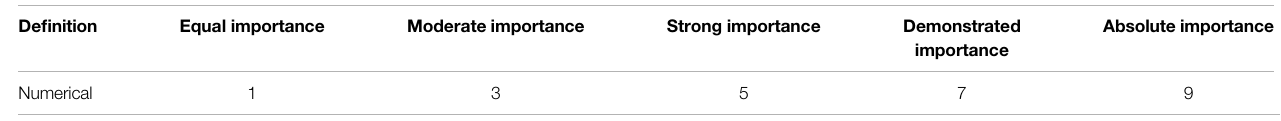
TABLE 2 | Pairwise comparison scale for AHP preferences.